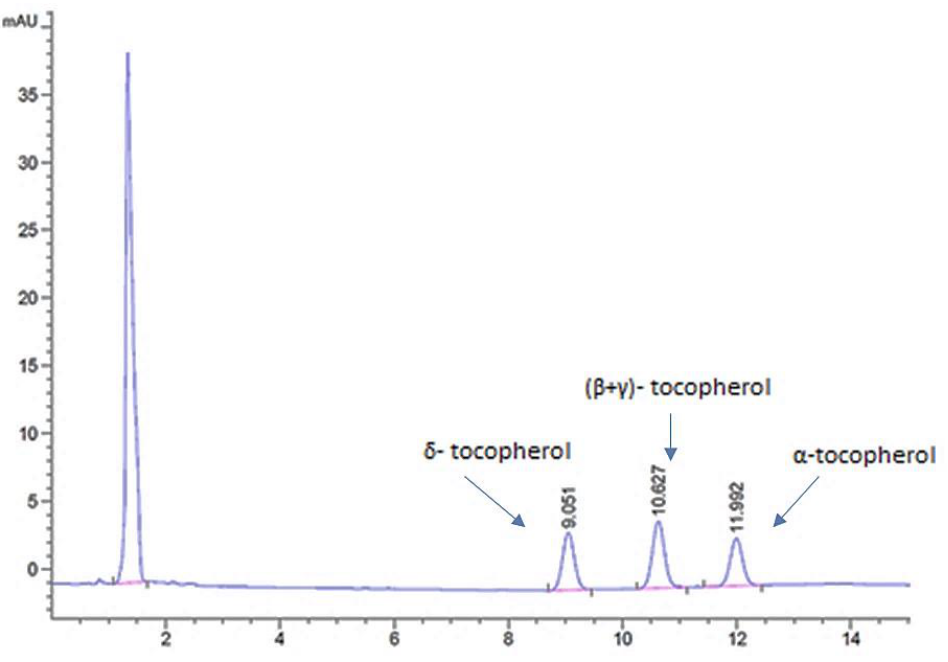
Table 3. Recovery (%R) rates for the evaluation of the reproducibility.